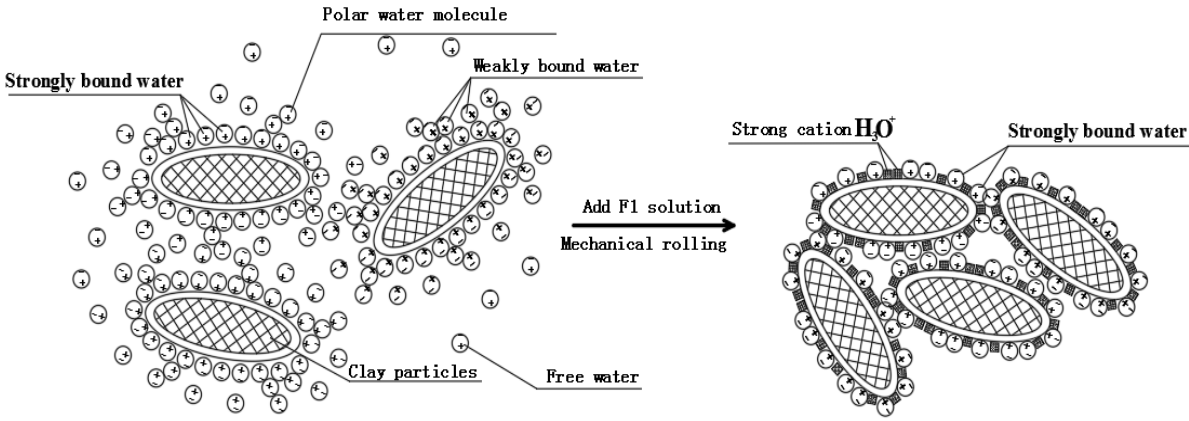
Figure 1. Microscopic schematic diagram of F1 reinforced soil.